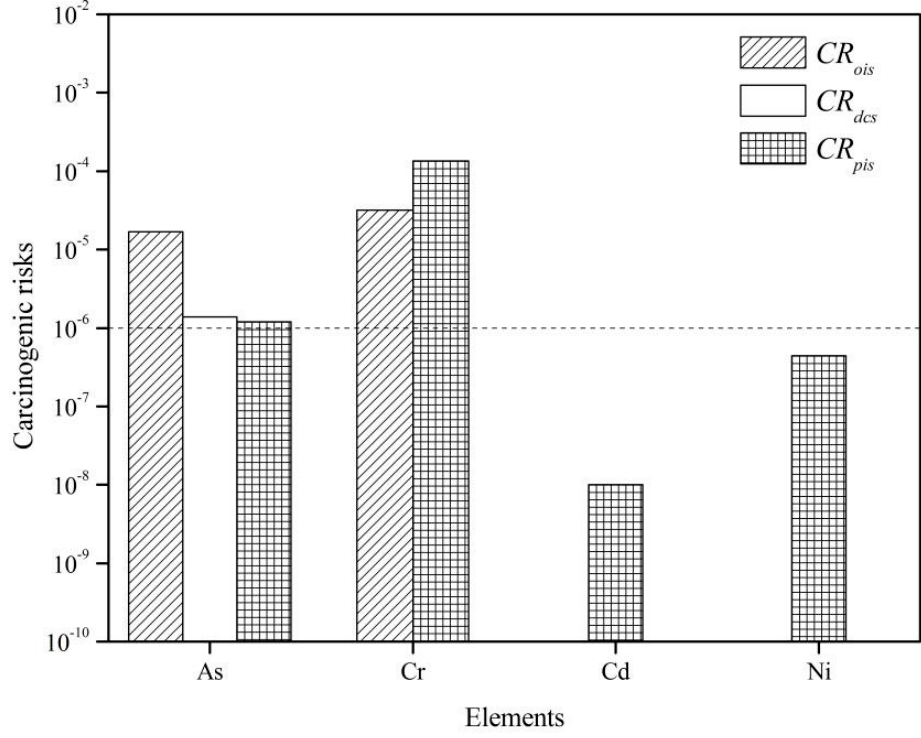
Figure 5. Carcinogenic risks of heavy metals in topsoils around industrial sites in